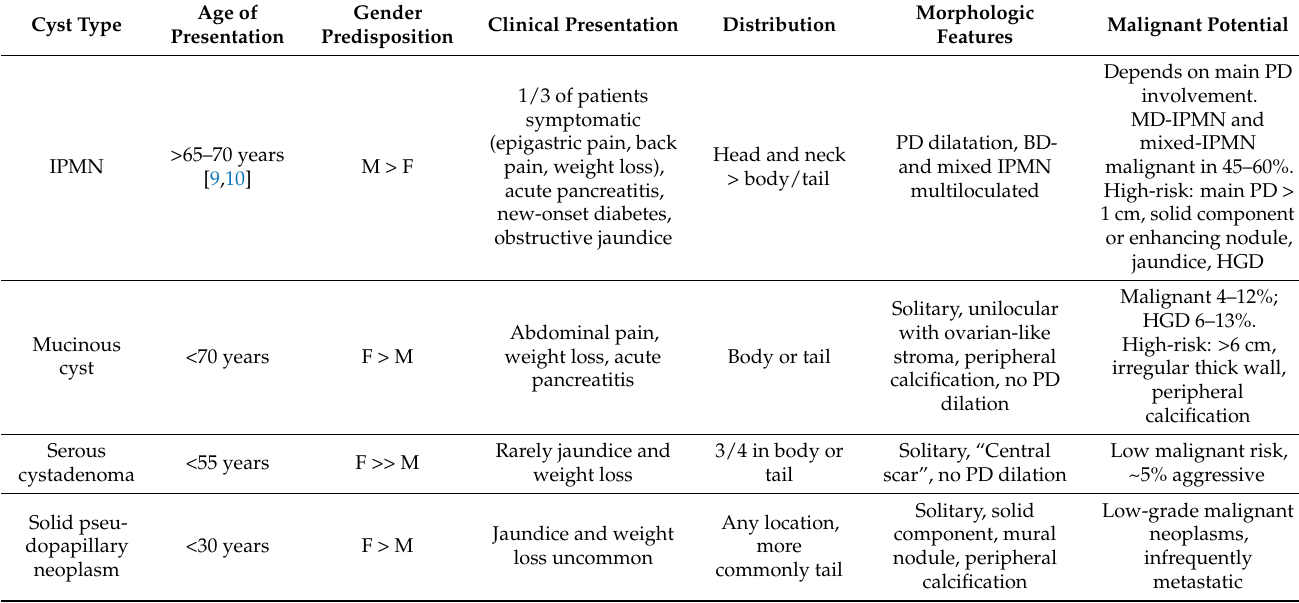
Table 1. Clinical and demographic features of pancreatic cysts.